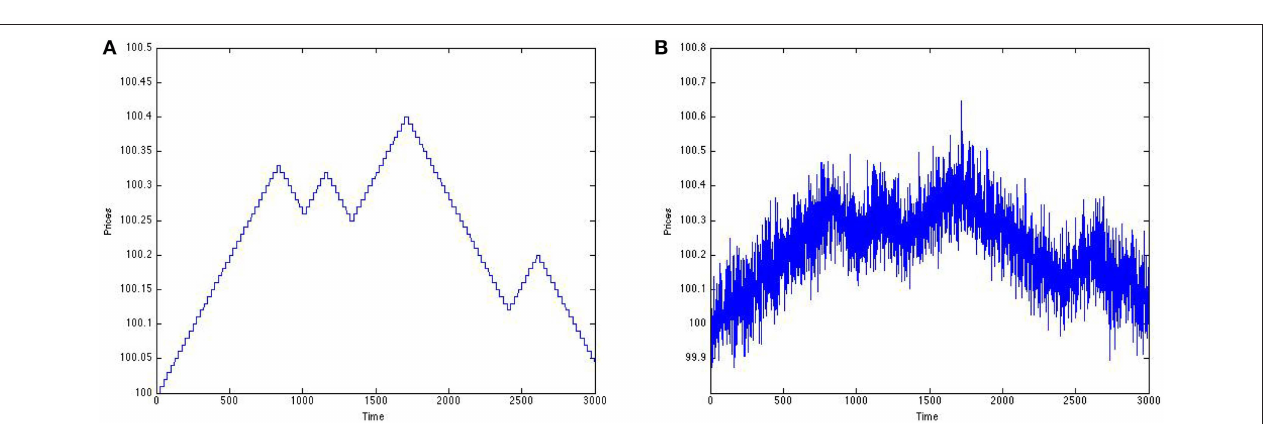
FIGURE 13 | Increase in correlation coefficient as a function of added noise intensity to signal in Figure 12B (using 10,000 units).